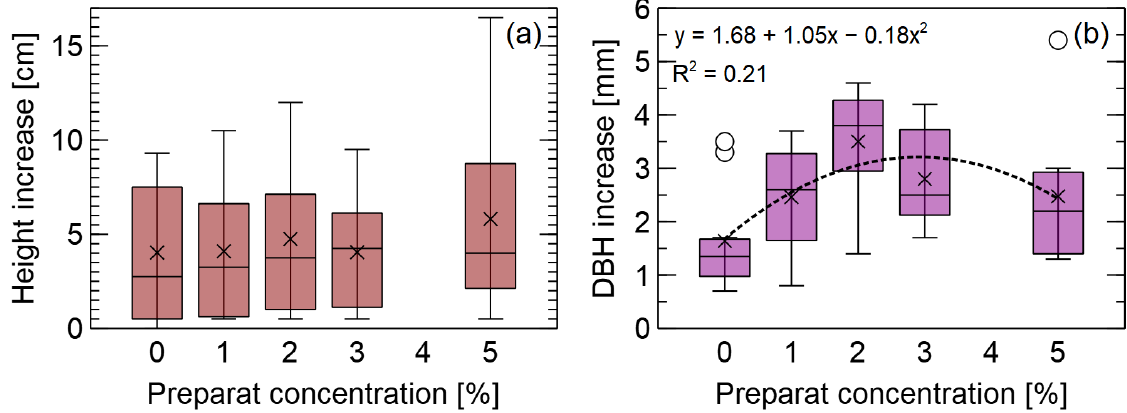
Figure 4. Pine seedlings’ height increases ( a ) and diameter at breast height—DBH—increases ( b ) ver- sus silicon concentration. Comparison of the magnitude differences after the third application of the treatment, and at the beginning of the experiment. In sub-Figure ( b ), the dashed curve represents the linear regression fit of the data. The regression equation with the fitted parameters and the model’s R 2 values are printed. The regression parameters are statistically significant at p < 0.0033. For the case presented in sub-Figure ( a ), the regression parameters were not statistically significant at the p -value level of 0.05, thus, the fit is not presented. In the plots, boxes span from the 1st to 3rd quantile, with the median indicated by a line, whiskers indicating 1.5 inter-quantile range, the × symbol indicating the mean value, and circles indicating outlier